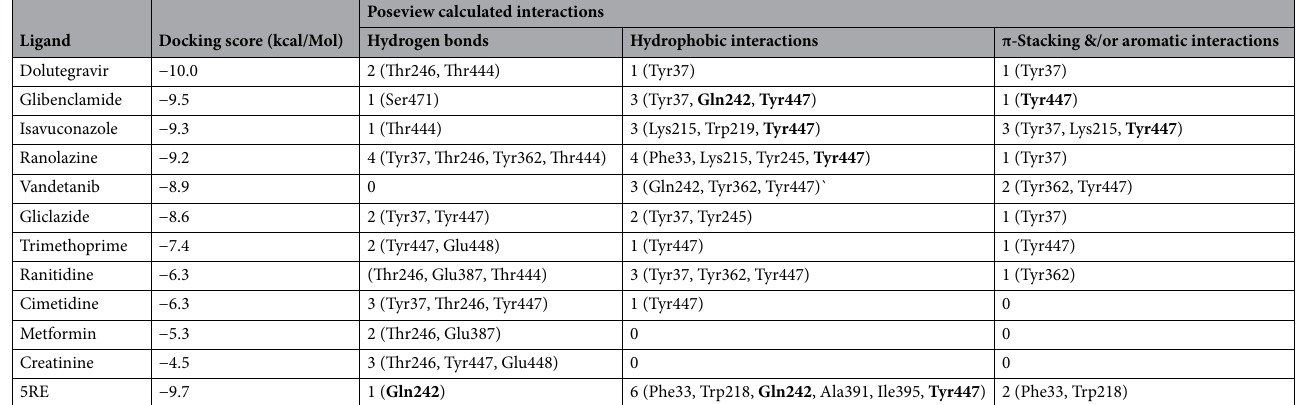
Table 10. Docking scores and number of interactions predicted for 11 drugs and 5RE inhibitor docked to the active site of SLC22A2 haplotype 5. Interactions calculated using Poseview. Number in front of brackets is the total number of interactions observed. Three letter aa code: Thr threonine, Tyr tyrosine, Ser serine, Lys lysine, Phe phenylalanine, Gln glutamine, Glu glutamic acid, Ala alanine, Ile isoleucine. The residues highlighted in bold shows similar interacting residues shared between the top binders: i.e. 5RE, Dolutegravir, Glibenclamide, Isavuconazole, and Ranolazine.